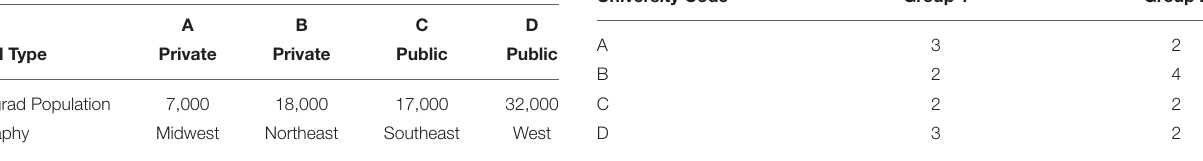
TABLE 1 | Basic characteristics of selected case study